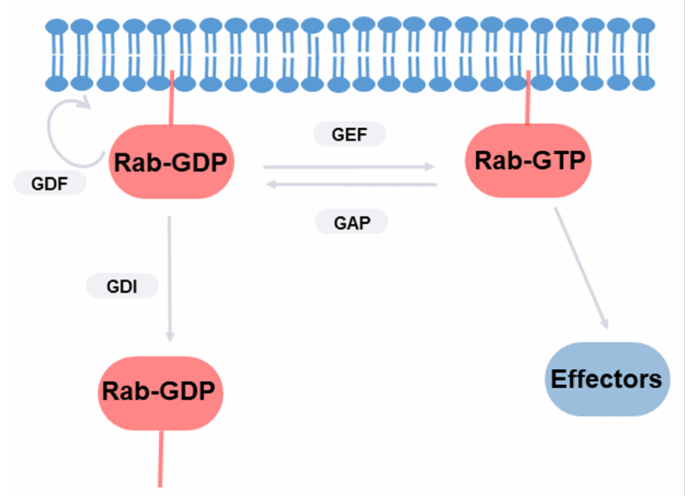
Figure 1. Regulation of GTP–GTP cycle of Rab GTPases by guanine nucleotide exchange factors (GEFs), GTPase-activating proteins (GAPs), GDP dissociation inhibitor (GDI), and GDI displacement factors (GDF). Membrane-associated GTP-bound Rabs are able to interact with